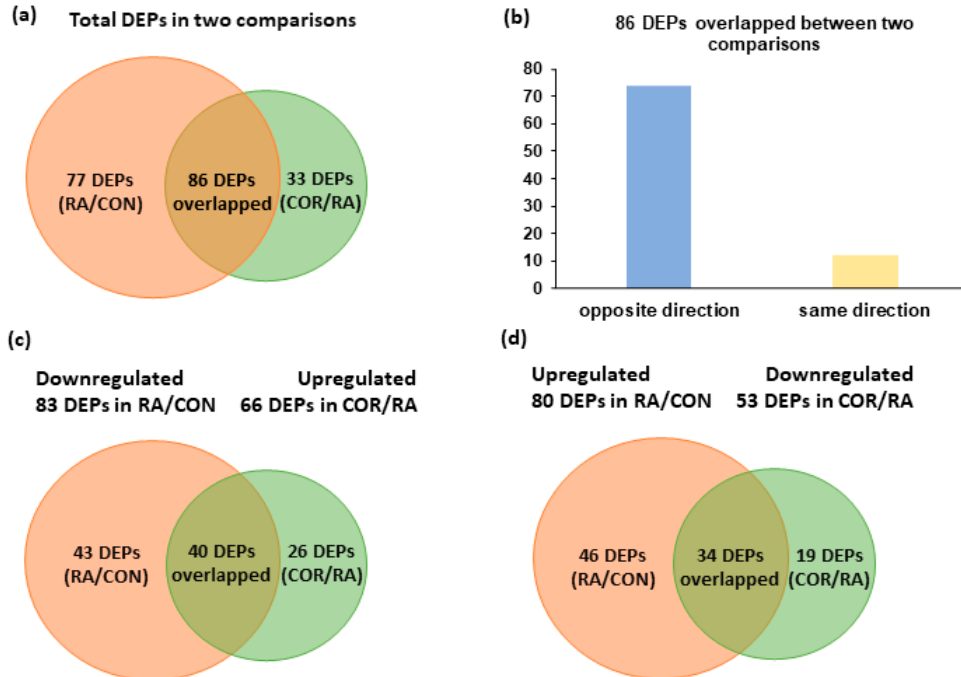
Figure 2. Differentially expressed proteins (DEPs) in the RA/CON and COR/RA comparison. The Venn diagrams show summaries of ( a ) DEPs in both comparisons, ( b ) overlapped DEPs in both comparisons, ( c ) DEPs with downregulated expression in the RA/CON comparison but with upregulated expression in the COR/RA comparison, and ( d ) DEPs with upregulated expression in the RA/CON comparison but with downregulated expression in the COR/RA comparison.